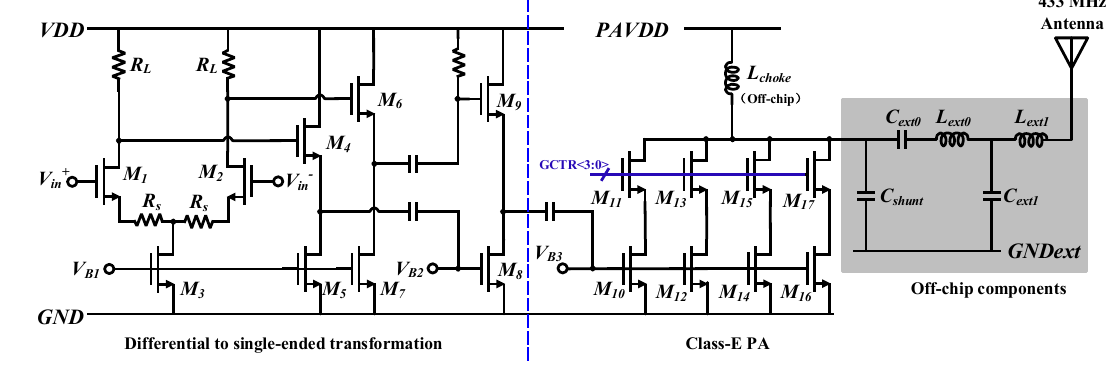
Figure 8. Schematic of class-E